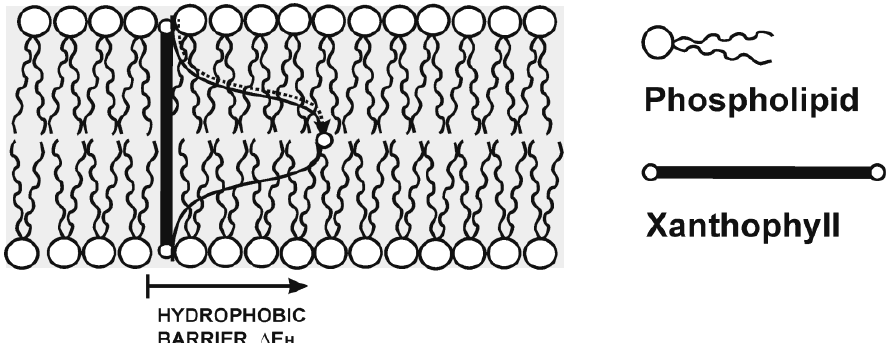
Figure 4. Schematic drawing explaining the physical stability of dipolar xanthophylls in the lipid-bilayer membranes. A hydrophobic barrier across the lipid bilayer is indicated. To remove the dipolar xanthophyll molecule from the bilayer, one of its polar −OH groups has to cross the hydrophobic (energy) barrier. ΔE H is the energy needed to pull the polar −OH group of the dipolar xanthophyll across this